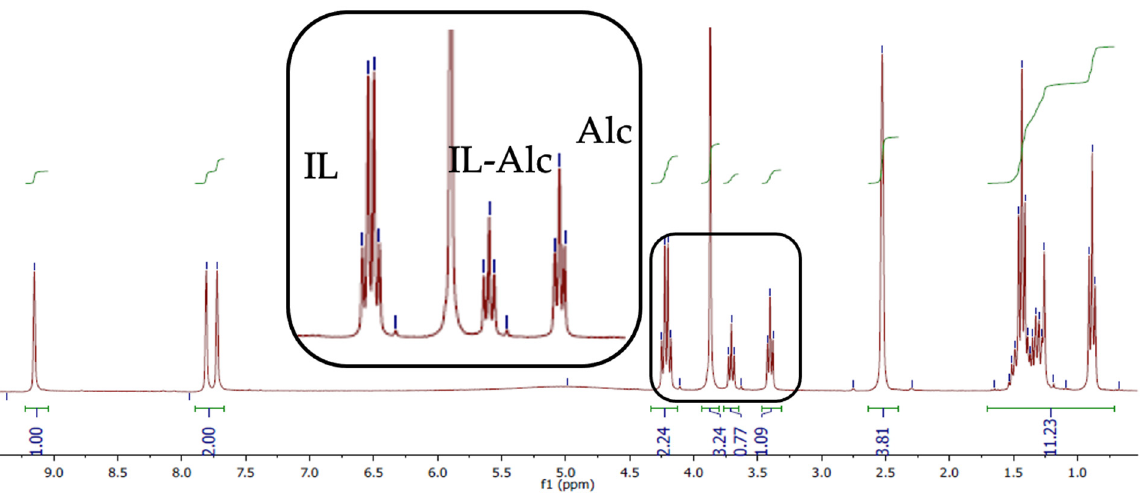
Figure 1. 1 H-NMR in d 6 -DMSO of the lower phase after extraction of 1-butanol/ n -tetradecane phase with ionic liquid at 393 K. Included is the expanded region of interest.